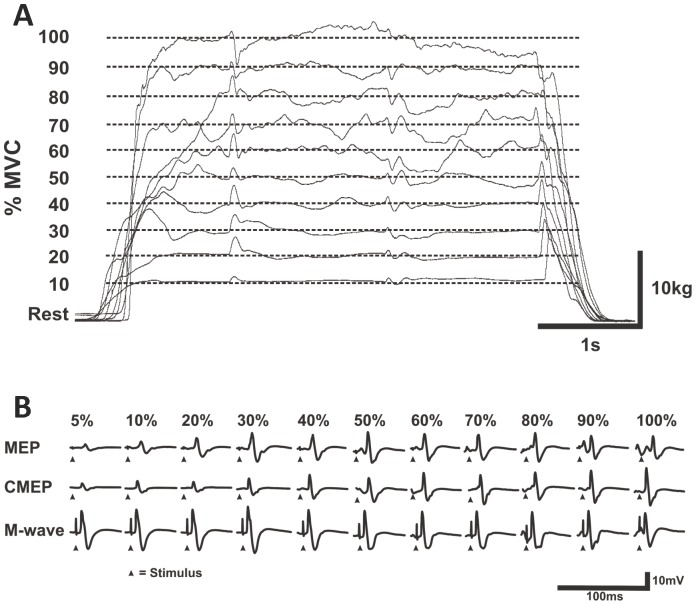
Force output from 10–100% MVC and corticospinal responses of the biceps brachii recorded from a chronic-RT subject.(A) Individual raw data traces from a single subject of one set of contractions from 10–100% MVC with the three stimuli: transcranial magnetic (MEP), cervicomedullary (CMEP) and brachial plexus stimulation (M-wave). Additional force is superimposed on the actual force following each stimulus at each contraction intensity. (B) Individual raw data traces from the same subject showing EMG responses (MEP-top, CMEP-middle, and M-wave-bottom) of the biceps brachii following each stimulus. Arrows indicate the time of stimulation.